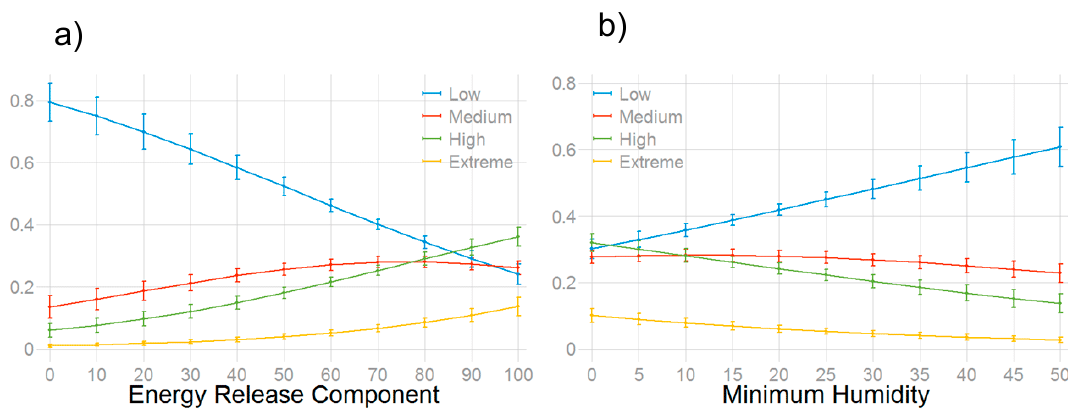
Figure 4. Predicted Probabilities of Growth Potential as a function of ( a ) the Energy Release Component and ( b ) Relative Humidity (%). The lines represent point estimates, while the bars represent 95% confidence intervals.